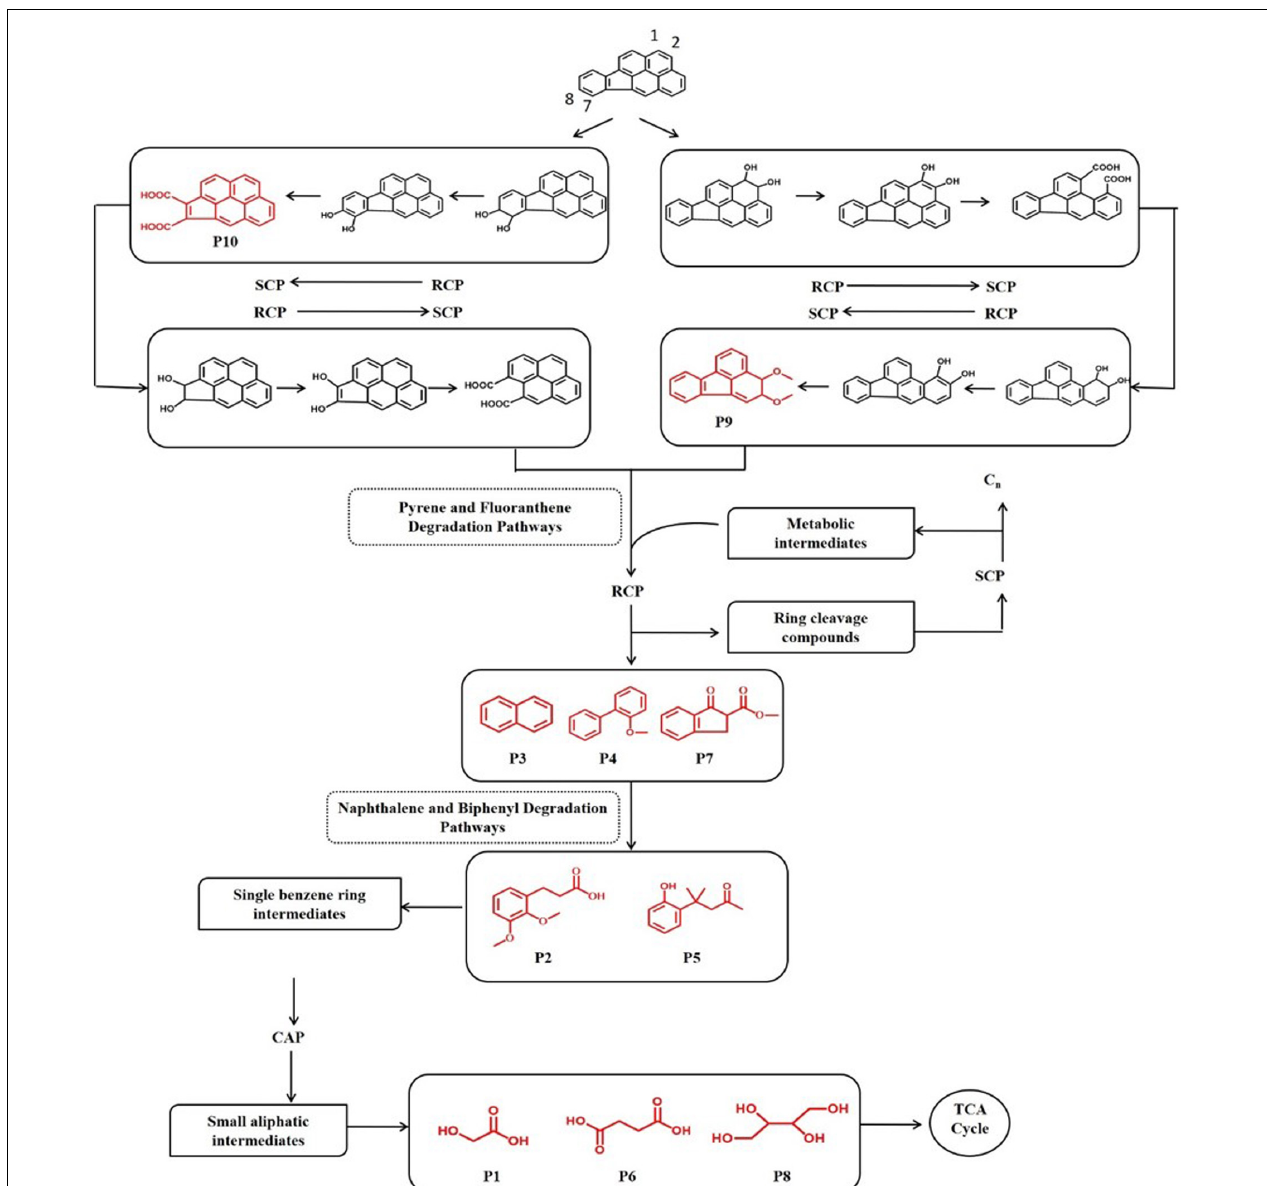
FIGURE 3 | Proposed IcdP degradation pathways in strain IcdP1. Identified molecules through GC-MS are shown in